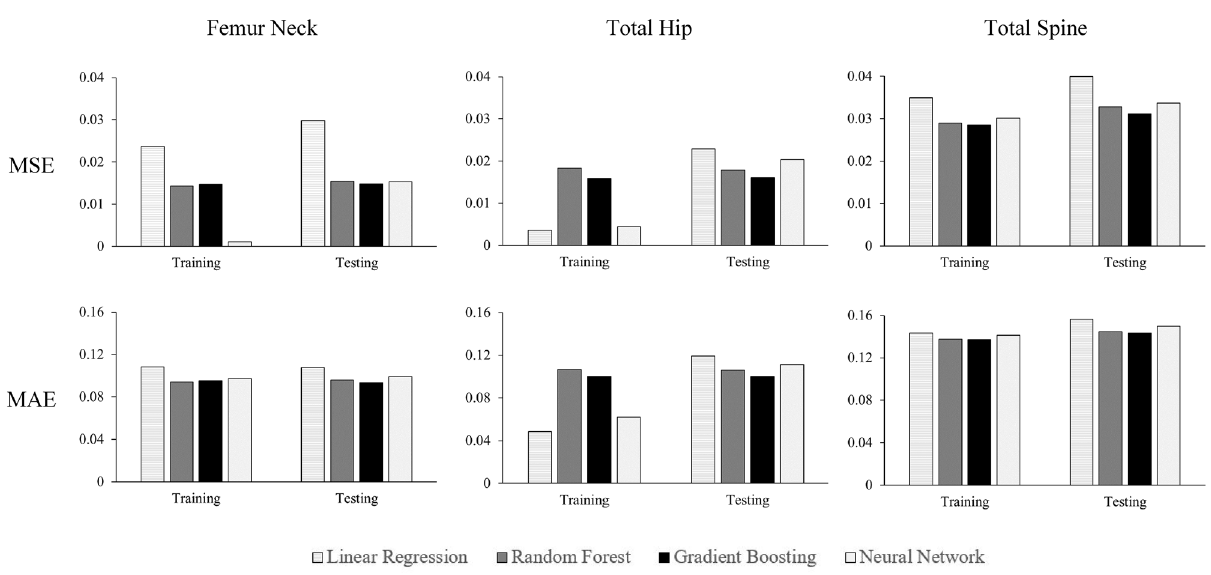
Figure 2. Mean square error (MSE) and mean absolute error (MAE) of different models in predicting various BMD in training (n = 4104) and testing (n = 1026); 1103 individual risk SNPs and phenotypic covariates were used as predictors. Lasso regularization, with the penalized value of 0.01, was applied to linear